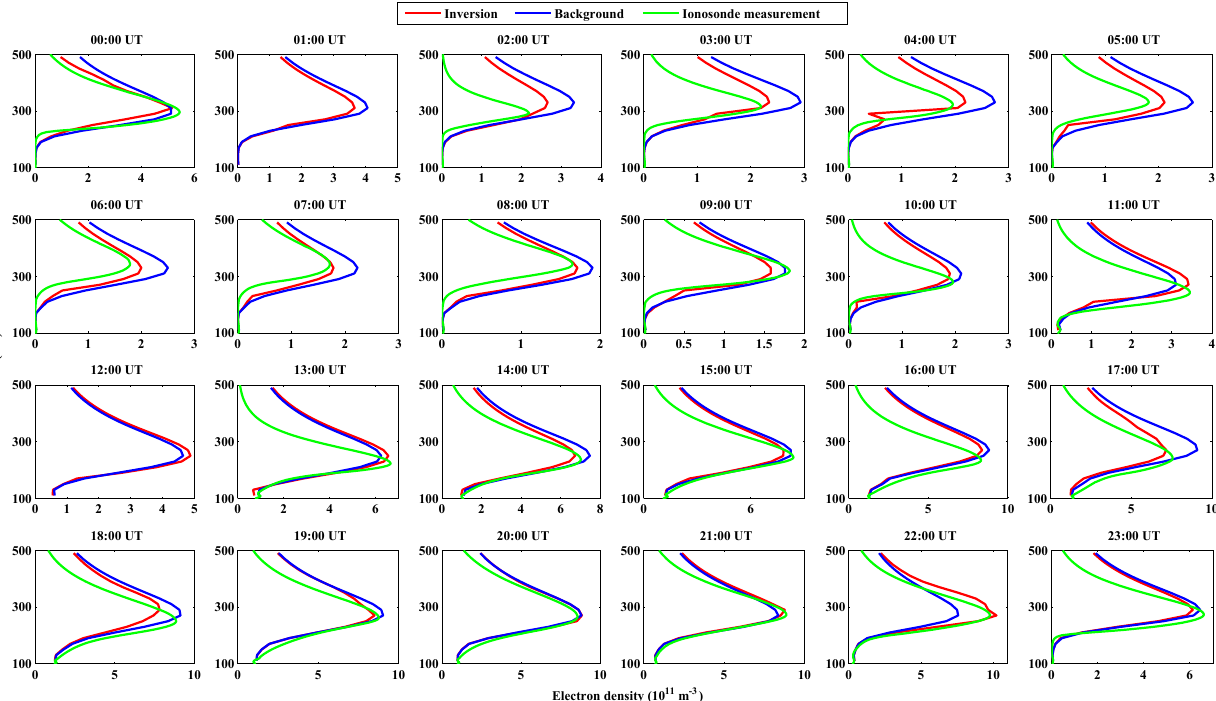
Figure 11. The comparisons between the reconstructed electron density profiles near the MHJ station and the measured electron density profiles from ground ionosonde under the relatively quiet geomagnetic activity condition; LT = UT −